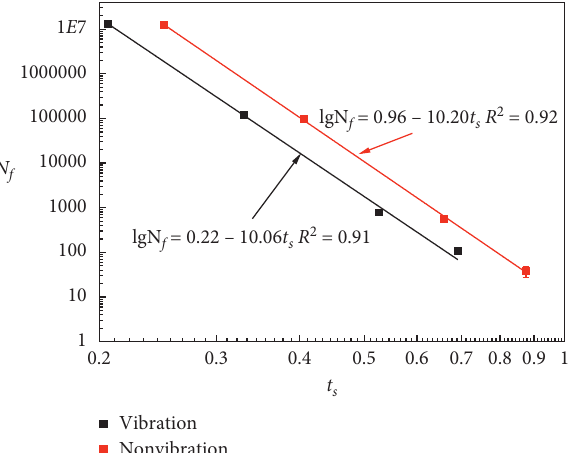
Figure 14: Four-point bending fatigue curve based on real stress ratio of specimens prepared by different mixing techniques.